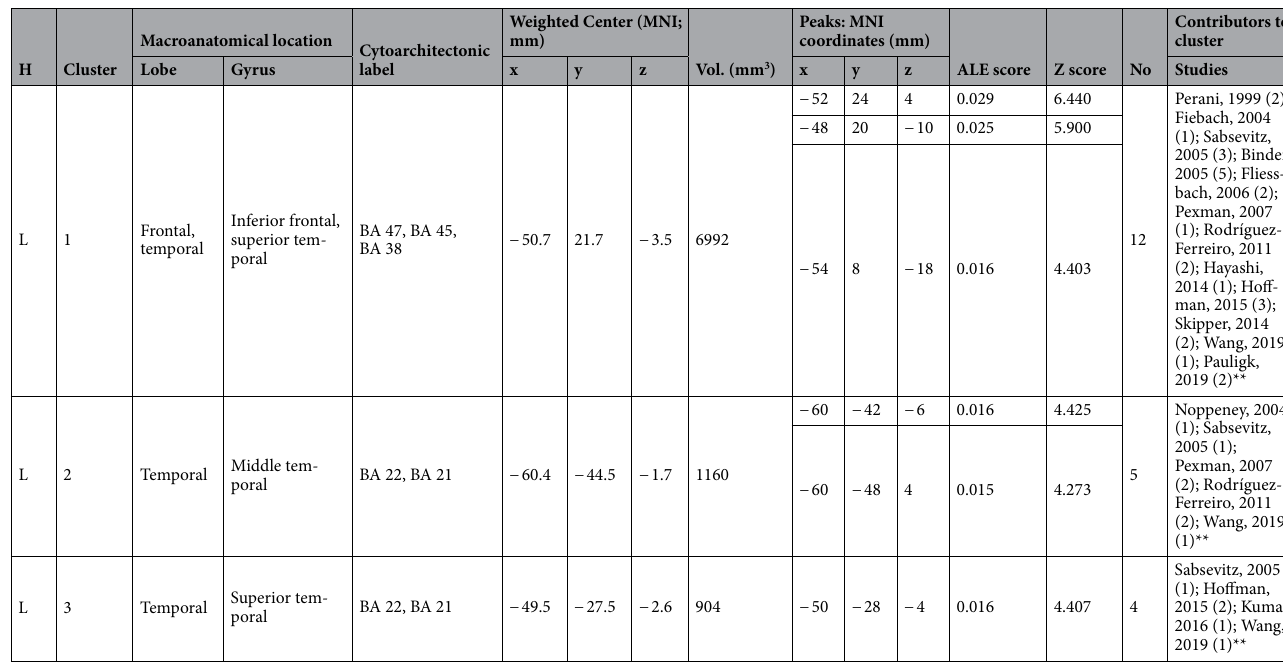
Table 8. Abstract > concrete words—visual stimuli- clusters. Included 135 stereotactic activation loci from 22 studies, 374 participants, chosen min. cluster size 688 mm 3 . All the values and labels were extracted from the GingerALE output files. Clusters are ordered for decreasing volume size. Coordinates (x, y, z) are in the MNI space. H = Hemisphere; ALE = activation likelihood estimation; Nr. = number of studies that contributed to